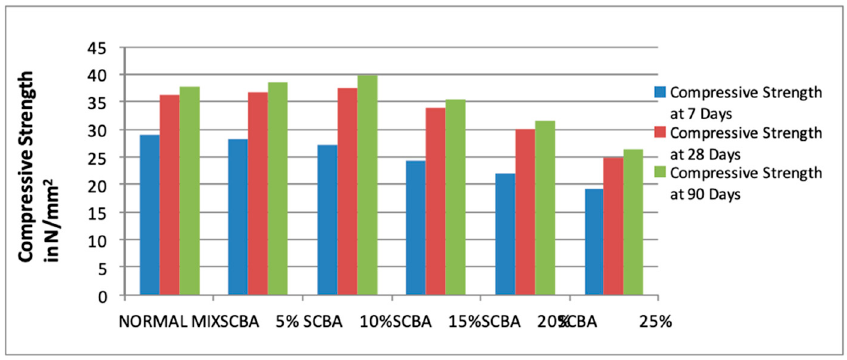
Figure 4. Compressive strength for the concrete mixes after 7, 28, and 90 days [36].